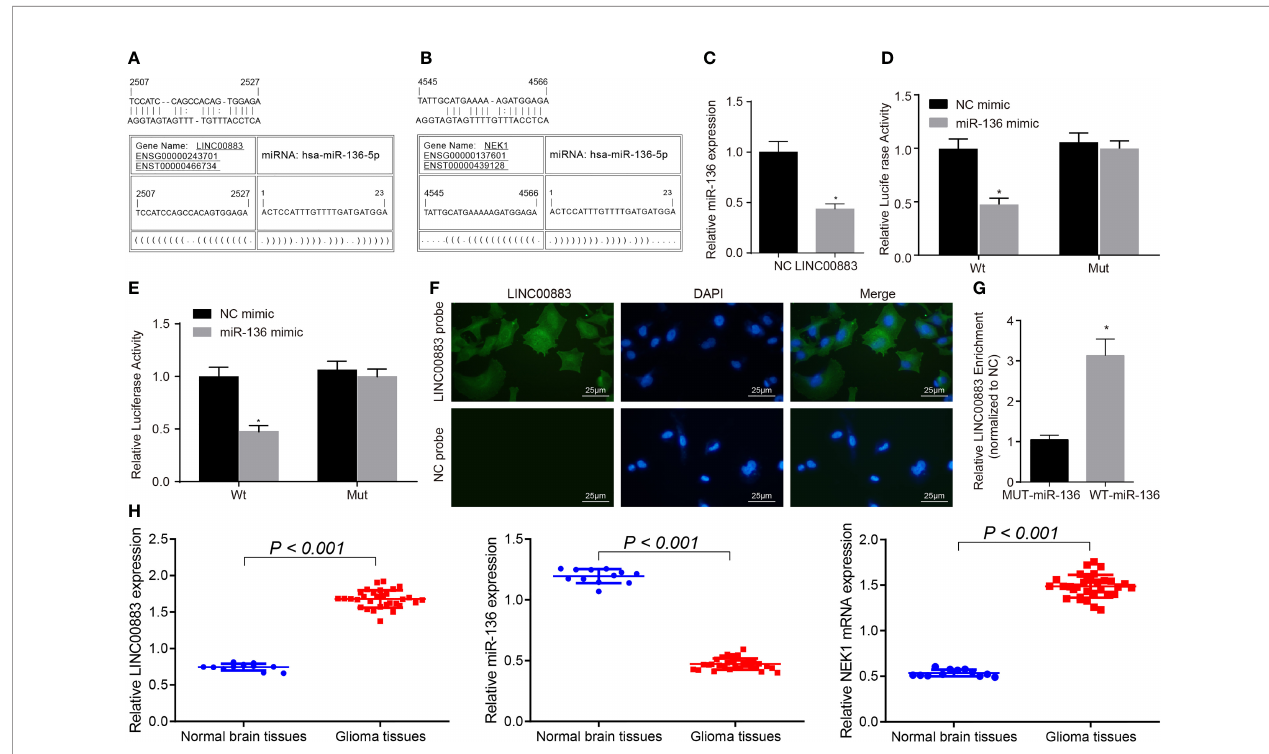
FIGURE 1 | LINC00883 may increase the expression of NIMA-related kinase 1 (NEK1) by binding to miR-136. (A) Binding sites between LINC00883 and miR-136 as predicted by the RNA22 website. (B) Binding sites between NEK1 and miR-136 as predicted by the RNA22 website. (C) Determination of miR-136 expression after LINC00883 overexpression by RT-qPCR; * p < 0.05 vs . the NC group. (D) Binding between LINC00883 and miR-136 as con fi rmed by dual-luciferase reporter assay; * p < 0.05 vs . the NC mimic group. (E) miR-136 binding to NEK1 as con fi rmed by dual-luciferase reporter assay; * p < 0.05 vs . the NC mimic group. (F) Distribution of LINC00883 in cells as detected by RNA- fl uorescence in situ hybridization (FISH) test (×400). (G) The interaction between miR-136 and LINC00883 as veri fi ed by RNA pull-down and RNA-binding protein immunoprecipitation (RIP) assays; * p < 0.05 vs . the MUT-miR-136 group. (H) The expression of LINC00883, miR-136, and NEK1 in clinical tissues as examined by RT-qPCR; * p < 0.05 vs . the non-neoplastic tissues. The measurement data were expressed as mean ± standard deviation and analyzed by unpaired t -test. Biological and technical experimental replicates were performed in